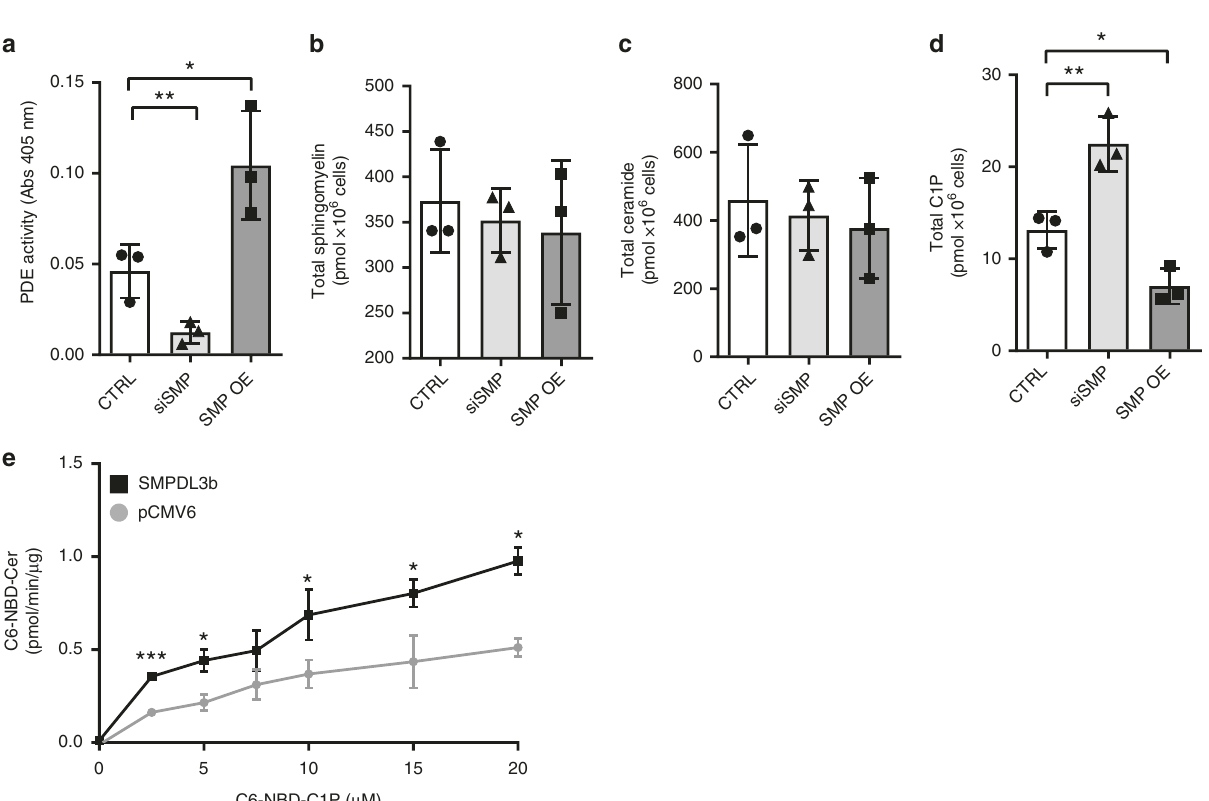
Fig. 1 SMPDL3b affects the conversion of C1P to ceramide. a Bar graph analysis of phosphodiesterase (PDE) activity in control (CTRL), SMPDL3b knockdown (siSMP) and SMPDL3b overexpressing (SMP OE) human podocytes. n = 3 independent experiments; * P = 0.039, two-tailed t -test. b Liquid chromatography mass spectrometry analysis (LC – MS) of total sphingomyelin content in CTRL, siSMP, and SMP OE human podocytes. n = 3 independent experiments. P = 0.78, F = 0.26, one-way ANOVA. c LC – MS of total ceramide content in CTRL, siSMP, and SMP OE human podocytes. n = 3 independent experiments. P = 0.78, F = 0.78, one-way ANOVA. d LC – MS of total ceramide-1-phosphate (C1P) content in CTRL, siSMP, and SMP OE human podocytes. n = 3 independent experiments. * P = 0.045, ** P = 0.007, F = 32.58, one-way ANOVA. e C1P phosphatase in vitro assay using increasing amounts C6-NBD-C1P. n = 2 independent experiments in duplicate; * P < 0.05, *** P < 0.001; two-tailed t -test. Error bars represent standard deviation